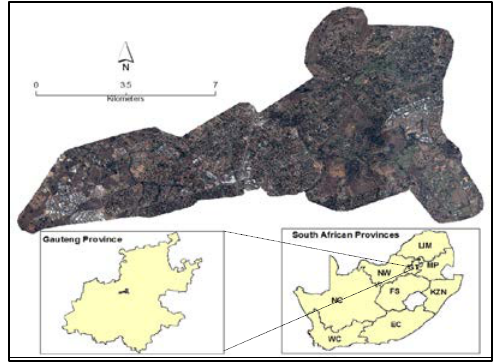
Figure 1: Location of Midrand, Gauteng province, South Africa